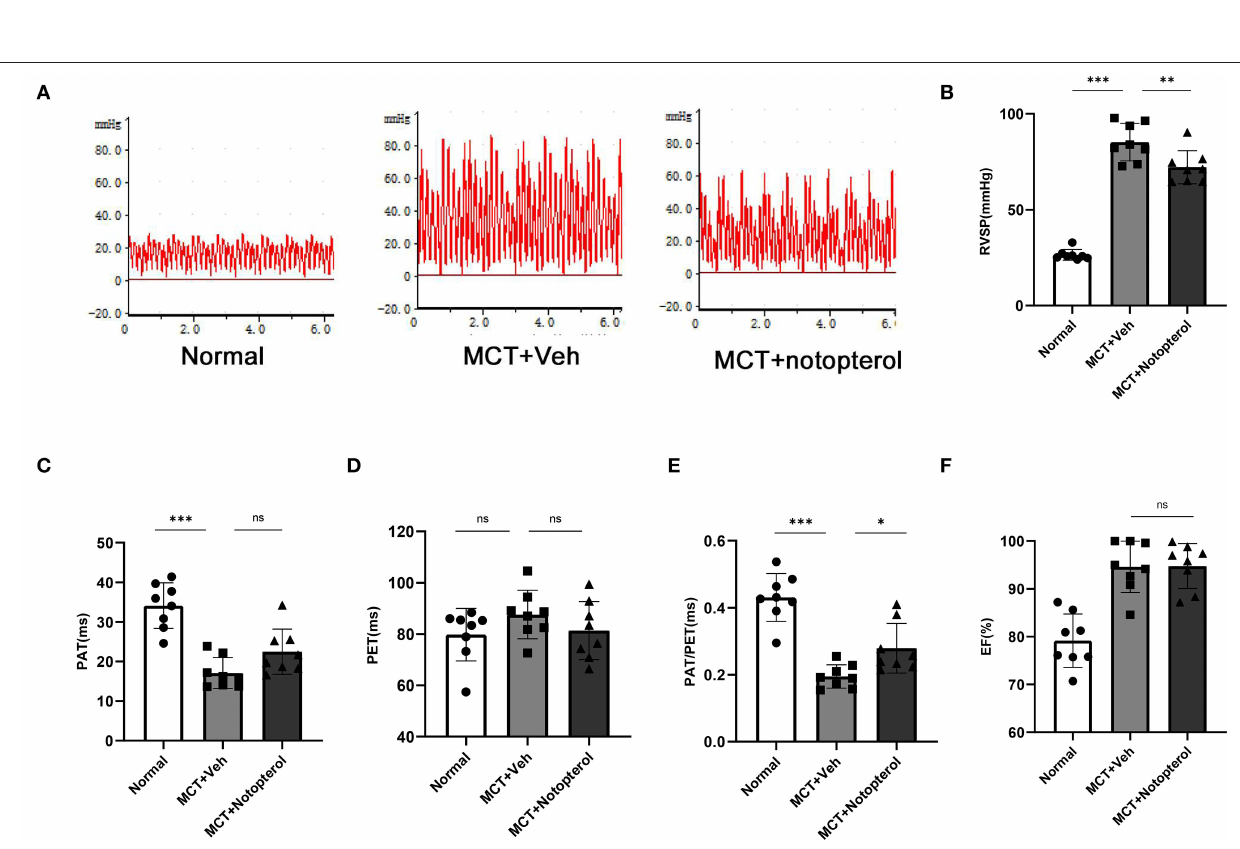
Frontiers in Cardiovascular Medicine |